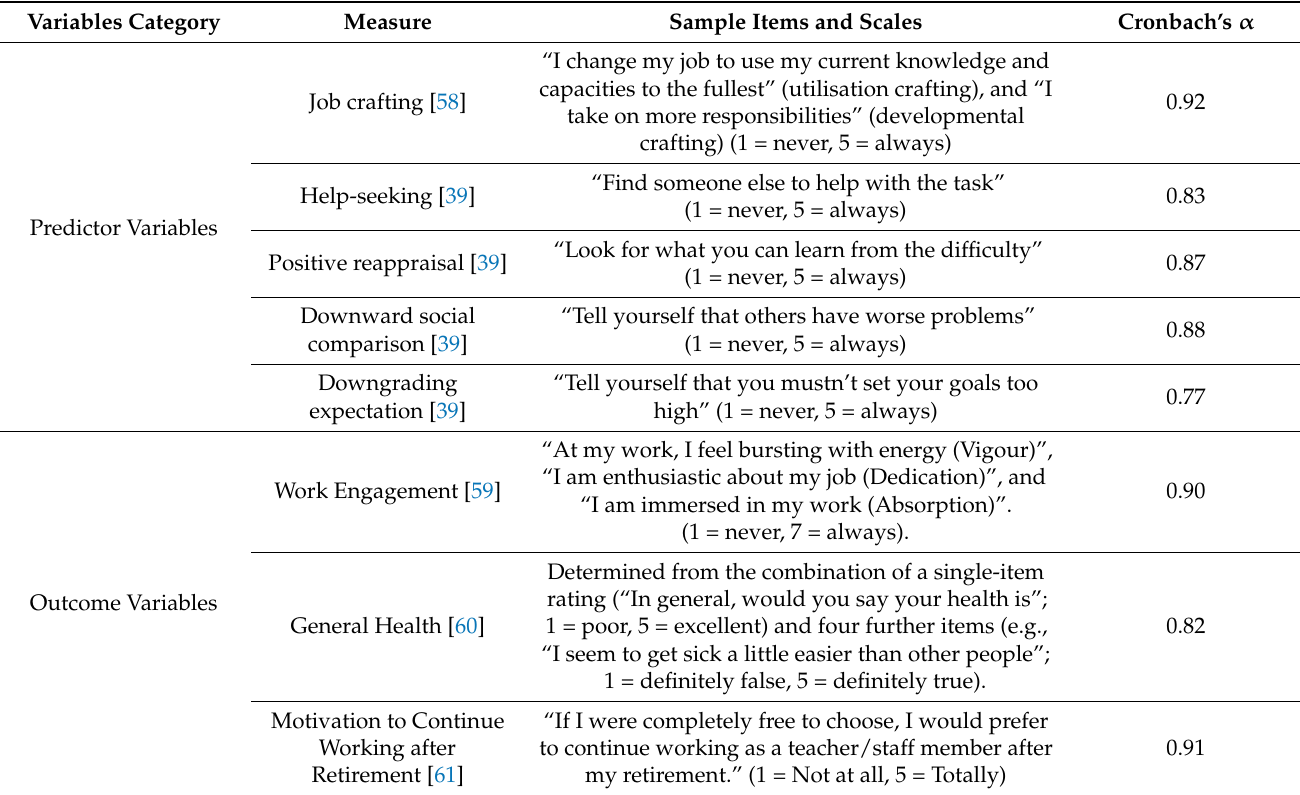
Table 2. Resources for measurement, sample items, and reliability of